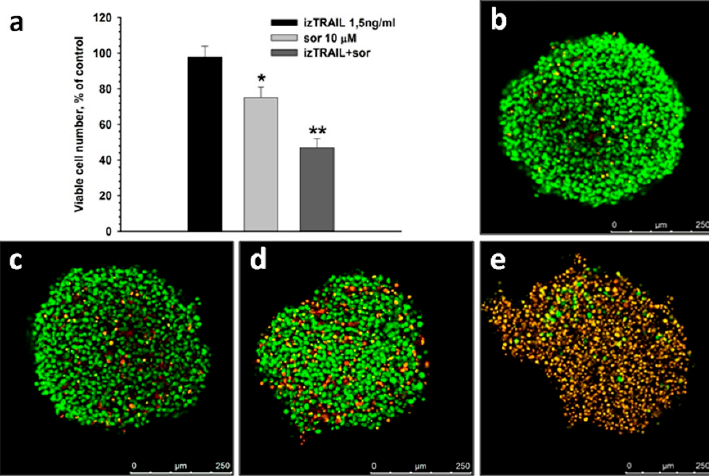
Figure 4. Suppression of TRAIL resistance of HT-1080 cells in spheroids by 10 µM sorafenib ( a ). ( b – e ) Confocal microscopy of the spheroids (merge of z-stacks). The cultures were stained with nuclear dyes H33342 and PI, 1 µg/mL each. Green nuclei—viable cells, yellow-red nuclei—dead cells. ( b ) control, without treatment; ( c ) in one day after the addition of 1.5 ng/mL izTRAIL; ( d ) in one day after the addition of 10 µM sorafenib; ( e ) in one day after the addition of 1.5 ng/mL izTRAIL and 10 µM sorafenib. n = 5, * р < 0.05, ** p < 0.01.